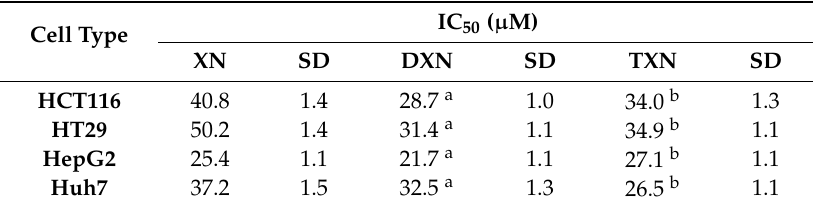
Table 1. XN, DXN, and TXN inhibit proliferation of human colon adenocarcinoma (HCT116 and HT29) and liver carcinoma (HepG2 and Huh7) cell lines. Mean IC 50 values ( ± SD) were calculated from cell growth curves ( n = 5, Figure